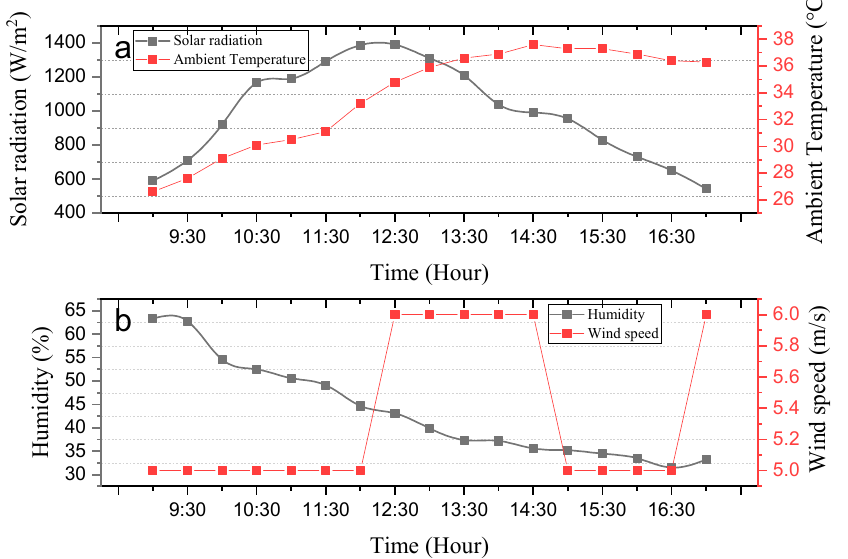
Figure 5. ( a ) Solar radiation and ambient temperature ( b ) humidity and wind speed characteristics for the experimental day